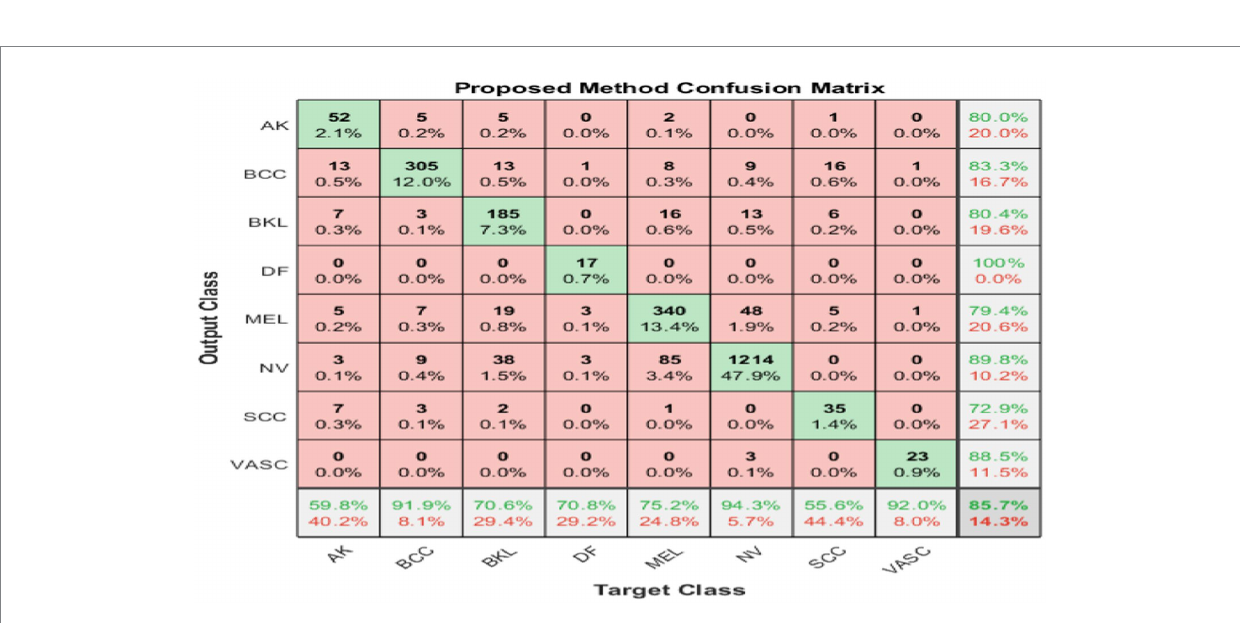
FIGURE 7 Resultant confusion matrix after contradiction resolving via SVNSs